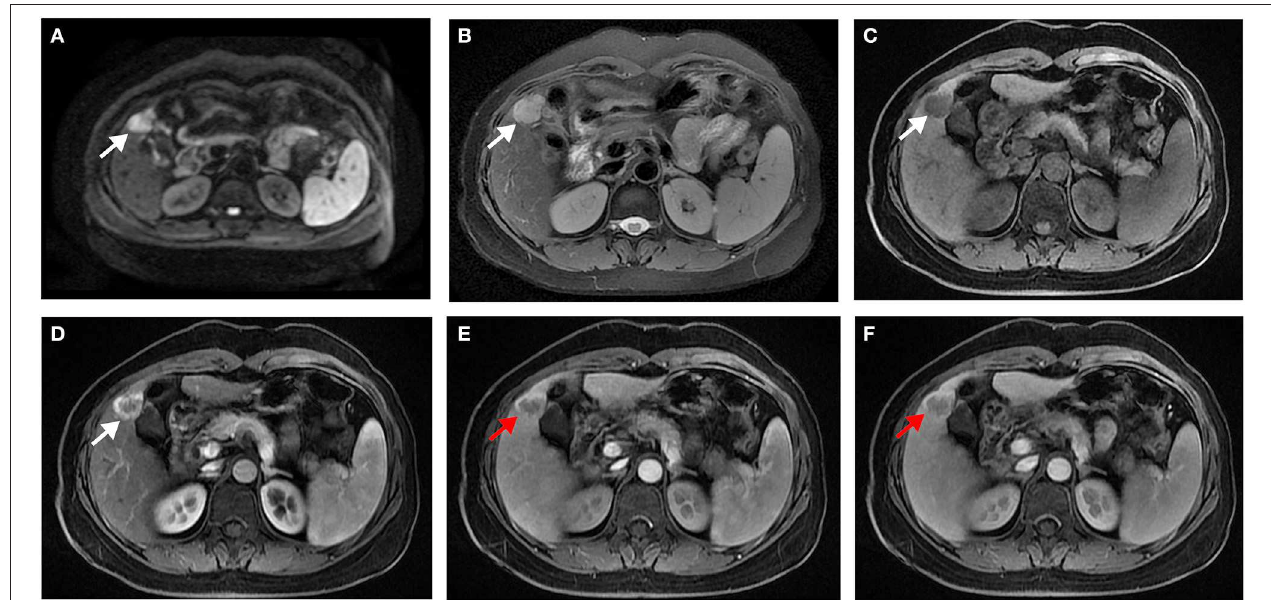
FIGURE 4 | Surgically confirmed moderately differentiated HCC with AFP = 520ng/mL. MR imaging showed a hepatic nodule (2.8cm, arrow) in S4/5 with restricted diffusion (A) and mild-moderate T2 hyperintensity (B) . The nodule is hypointense on precontrast T1WI (C) and shows hyperenhancement in late arterial phase (D) , and irregular tumor margin (red arrow) on portal venous (E), and delayed (F) phase. Histology confirmed MVI (–). This patient recurred 5 months after resection.